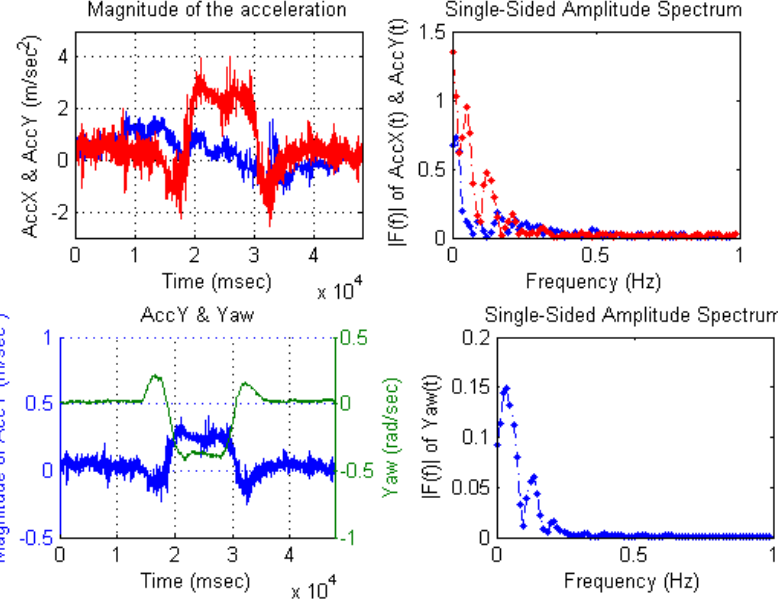
Figure 6. Time-domain and frequency-domain representations of X-axis, Y-axis acceleration and Yaw rotation